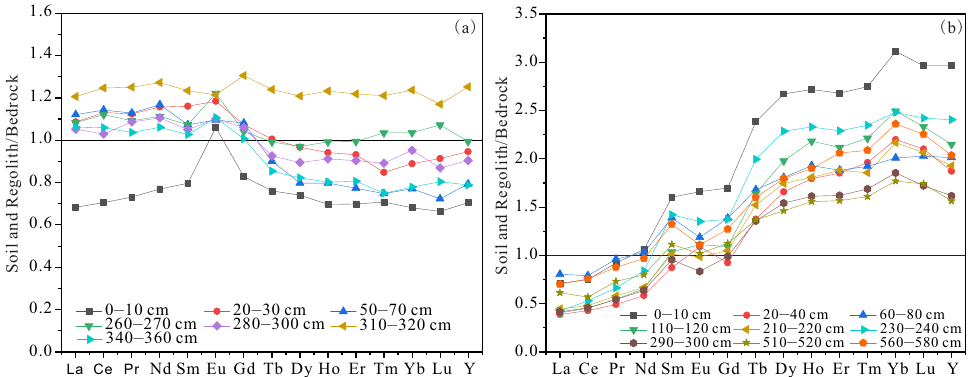
Figure 6. Bedrock-normalized REE patterns in profiles in NGH. ( a ) Profile 1; ( b ) Profile 2. The clays and iron (hydro) oxide that formed during chemical weathering in hornblende- gneiss locations were notably different, resulting in apparent different fractionations within REEs [46–50], since the mixed speciation of the REEs in clays and Fe-Mn oxyhydroxides is typical for REEs in soils [38,51–53]. Under natural pH, clay minerals with a negative layer charge are effective in the adsorption of REEs through ion exchange, surface complexation, electrostatic attraction and migration into clay structures [54]. The adsorption capacity is largely determined by the surface structure, surface charge of clay minerals and compo- sition [55,56]. In our study area, under alkaline conditions (pH > 7) with abundant Fe 2 + , Mg 2 + , and K + , clay minerals were dominated by smectite, illite or chlorite, especially in profile 2 [46,50,57,58]. Smectite and illite may intrinsically retain HREE more efficiently than LREE [46,58]. As shown in Figure 7a, LREE/HREE had a remarkable positive relation- ship with SiO 2 /(Al 2 O 3 +Fe 2 O 3 ) in profile 2 according to Pearson correlation analysis. As weathering proceeded, clay minerals were gradually generated from aluminosilicate miner- als with the enrichment of Al 2 O 3 and depletion of SiO 2 . In addition, enhanced oxidation contributed to the enrichment of Fe 2 O 3 . Therefore, the decrease of the SiO 2 /(Al 2 O 3 +Fe 2 O 3 ) ratio showed the enrichment of clay mineral (smectite and illite) and iron (hydro) oxide, favoring the preferential adsorption of HREE and fractionation within REEs [59]. However, according to CIA, the chemical weathering in profile 1 (CIA = 65.0–71.1) was generally stronger than that in profile 2 (CIA = 51.1–67.2), and a small amount of kaolinite and boehmite with higher maturity was formed from illite/smectite [60]. Therefore, LREEs were preferentially adsorbed by kaolinite in profile 1. In addition, HREEs have a smaller ionic radius and stronger hydrolysis ability than LREEs and therefore have a higher affinity toward iron (hydro) oxide. Previous studies also showed that the chondrite-normalized iron (hydro) oxide fractions are slightly enriched in HREEs via inner-sphere complexation and may play an important role in redistributing HREEs in the weathering crust [61,62]. As shown in Figure 7b, LREE/HREE had a remarkable negative relationship with Fe 2 O 3 in profile 2, suggesting the critical control of iron (hydro) oxide on the REE fractionation. In the study area, profile 2 contained more abundant Fe 2 O 3 (4.92–9.49%, 7.95%) than those in profile 1 (Fe 2 O 3 = 4.40–7.47%, 6.22% ). Therefore, in profile 1, HREEs are predominantly dissolved and migrate as bicarbonate and organic complexes in solution in case of the low contents of iron (hydro) oxide, leading to the fractionation of REEs among weathering crust [63–69]. However, the preferential scavenging of HREEs during the precipitation of pedogenetic iron (hydro) oxide resulted in the HREE enrichment in profile 2 instead of being dissolved and migrating as bicarbonate and organic complexes, which is consistent with the conclusion of Land (1999)